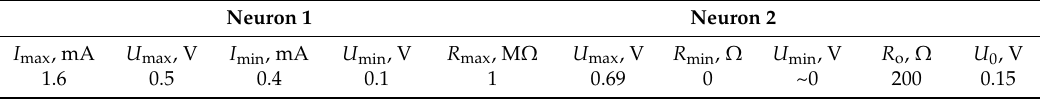
Table 2. Activation functions parameters of Neuron 1 ( U lpf ( I 0 ), Figure 5c) and Neuron 2 ( U lpf ( R ), Figure 5d). Current source in Neuron 2 I 0 = 0.15